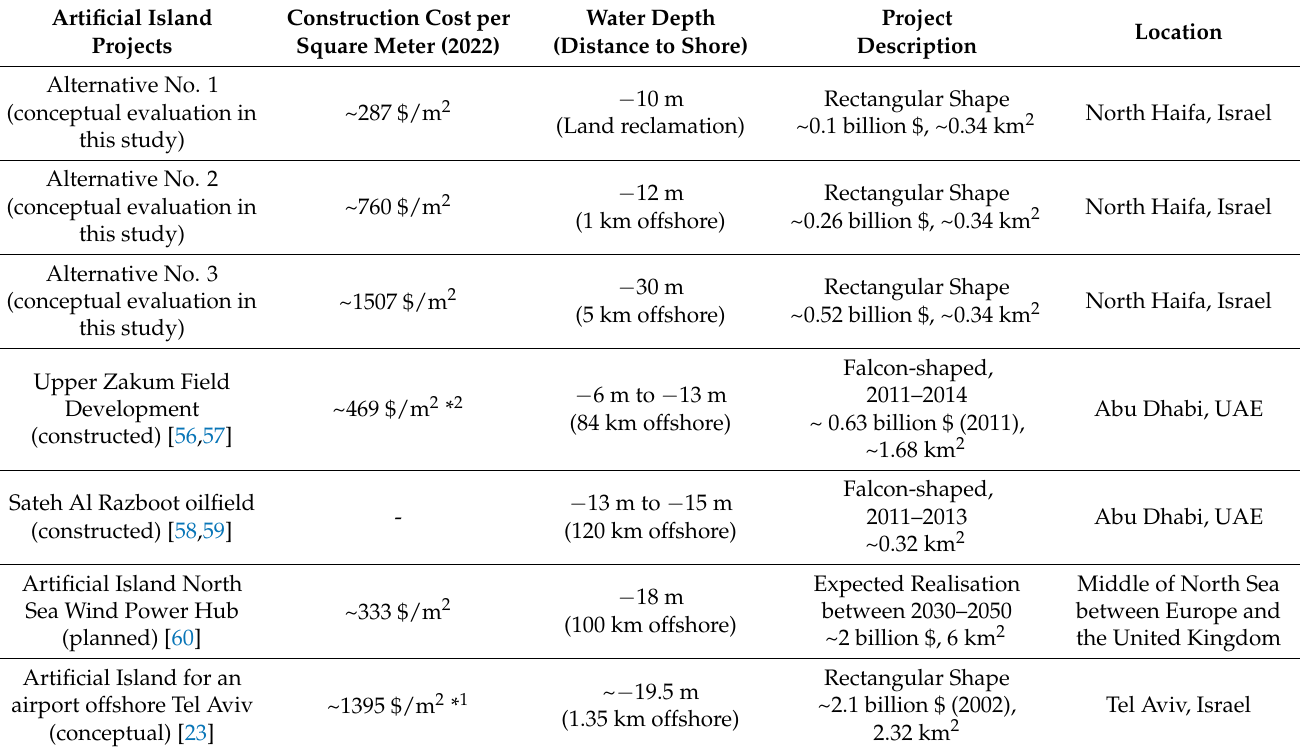
Table 6. Data of comparable artificial islands projects based on rubble mound